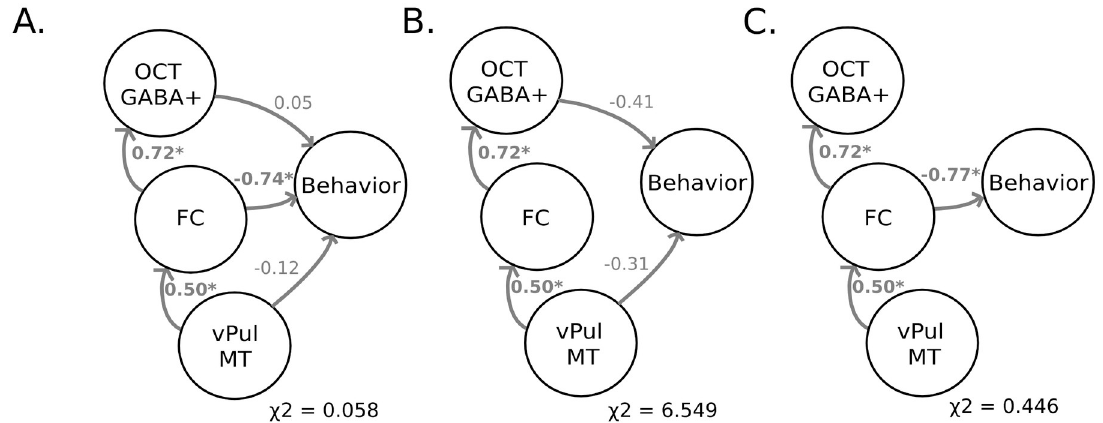
Fig 5. Linking microstructural, functional, and GABAergic plasticity to learning. (A) SEM modeling ( χ 2 = 0.058, p = 0.810) showed thalamocortical connectivity was a key predictor of behavioral improvement. ( B ) Setting this path to zero resulted in a significantly poorer fit to the data ( χ 2 difference = 6.491, p = 0.011). ( C ) Setting to zero the path of OCT GABA+ to behavior or pulvinar MT to behavior resulted in a similar model fit ( χ 2 difference = 0.388, p = 0.823) that did not differ significantly from the main model fit. Path lines and coefficients (completely standardized solution, β STD ) are shown in grey ( n = 14). Source data are provided at: https://doi.org/10.17863/ CAM.93457. MT, magnetization transfer; OCT, occipito-temporal